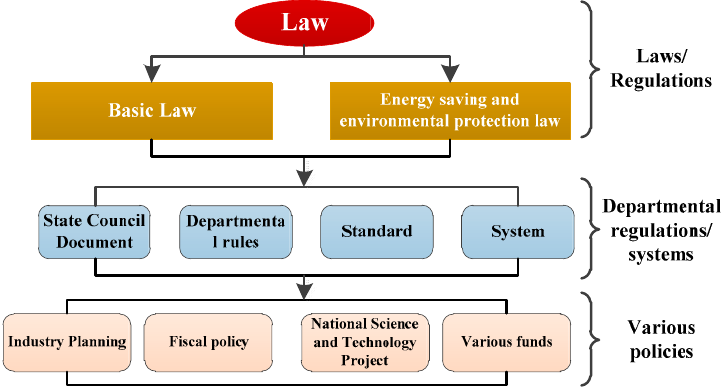
Figure 2. Existing policy framework system of green lighting industry.